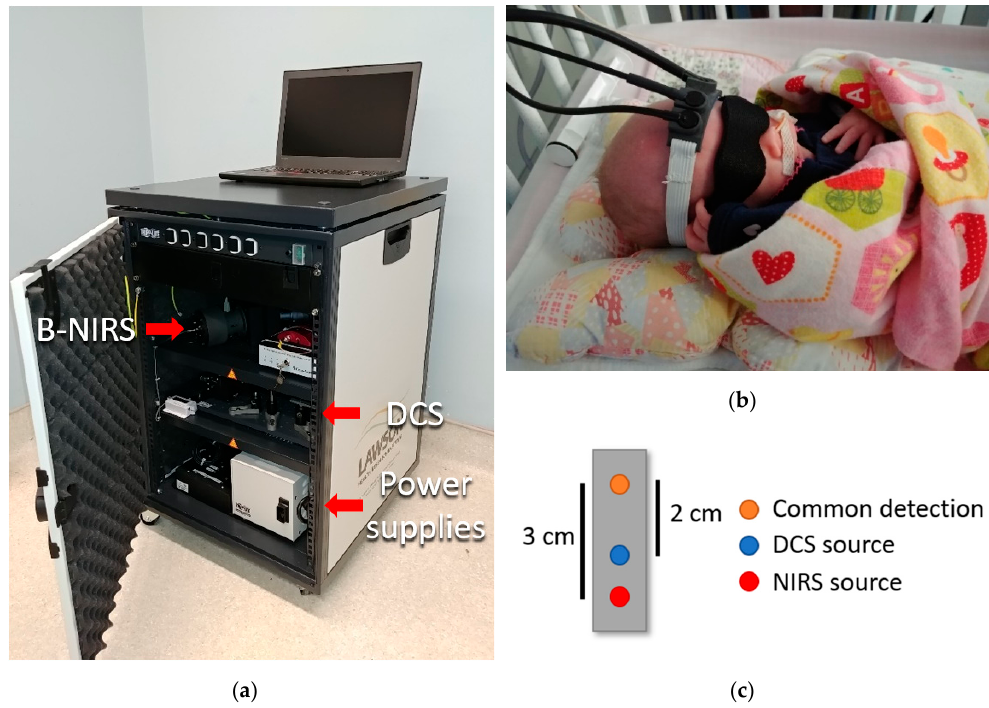
Figure 1. ( a ) Neonatal NeuroMonitor (NNeMo) combining broadband near-infrared spectroscopy